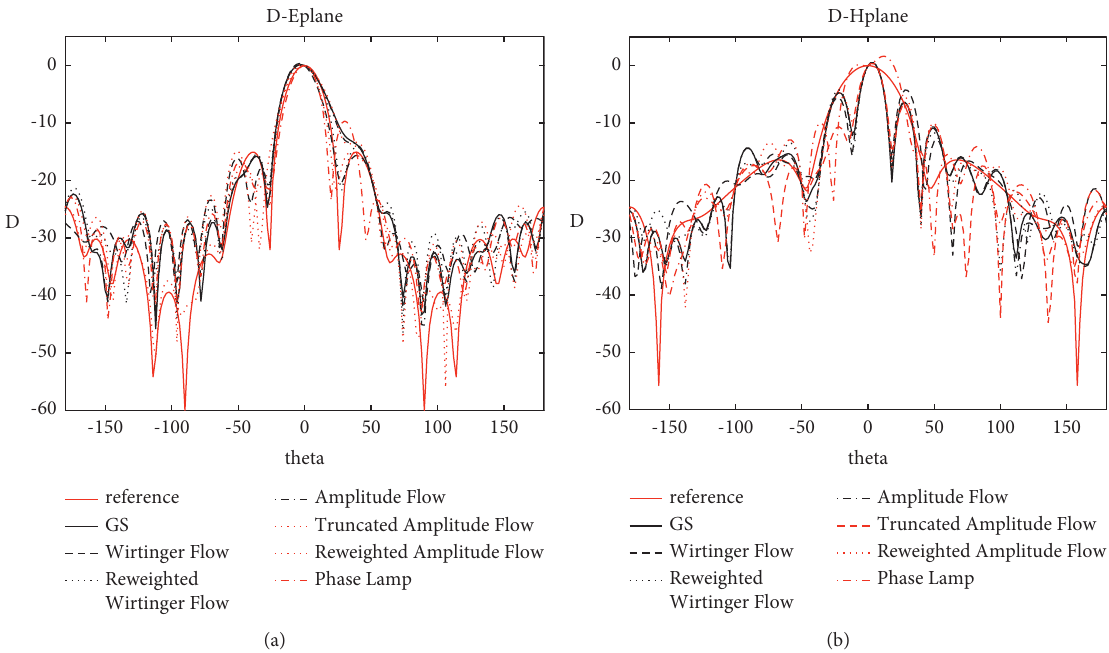
Figure 13: The obtained radiation pattern of dipole array by adopting other phase recovery algorithms. (a) E-plane. (b) H-plane.